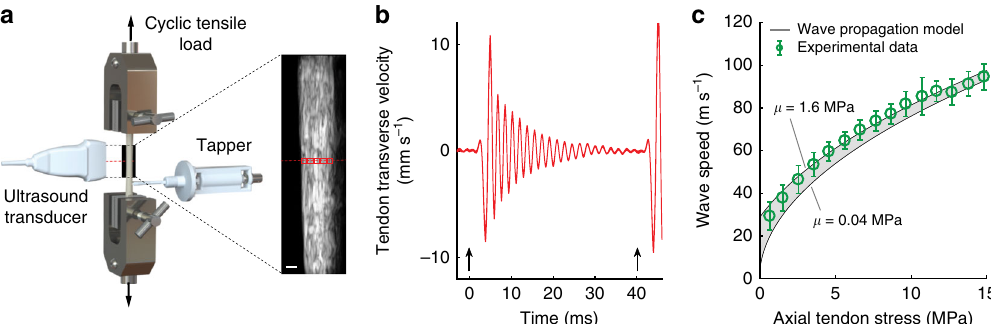
Fig. 1 Ex vivo experiment. a . Porcine tendons were clamped and cyclically loaded up to 300 N. A tapper device (Supplementary Fig. 2) delivered an impulsive 20 μ m tap in the transverse direction at 40 ms intervals. Ultrasound radiofrequency data were collected at 14,100frames per second from a single location along the tendon and used to track transverse tendon displacements. Scale bar, 2 mm. b An underdamped standing wave emerged in response to each tap (indicated by arrows) and was used to ascertain the natural frequency and corresponding shear wave speed. c Plotted are the mean (±1 s.d.) wave speeds versus the corresponding tendon stress for 10 porcine digital fl exor tendons. The shaded region re fl ects the wave speed predictions using the wave propagation model (Eq. 2) with the following parameters: ρ = 1730 kg m − 3 ; μ = 0.04 – 1.6 MPa; k ’ = 0.9 (see Supplementary